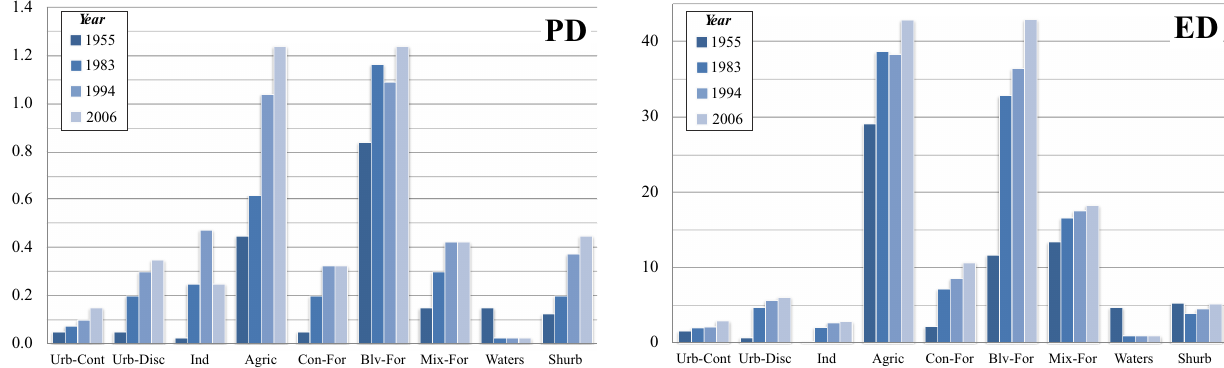
Fig. 10. Patch Density (PD) and Edge Density (ED) landscape metrics calculated at class level for all time intervals defined.